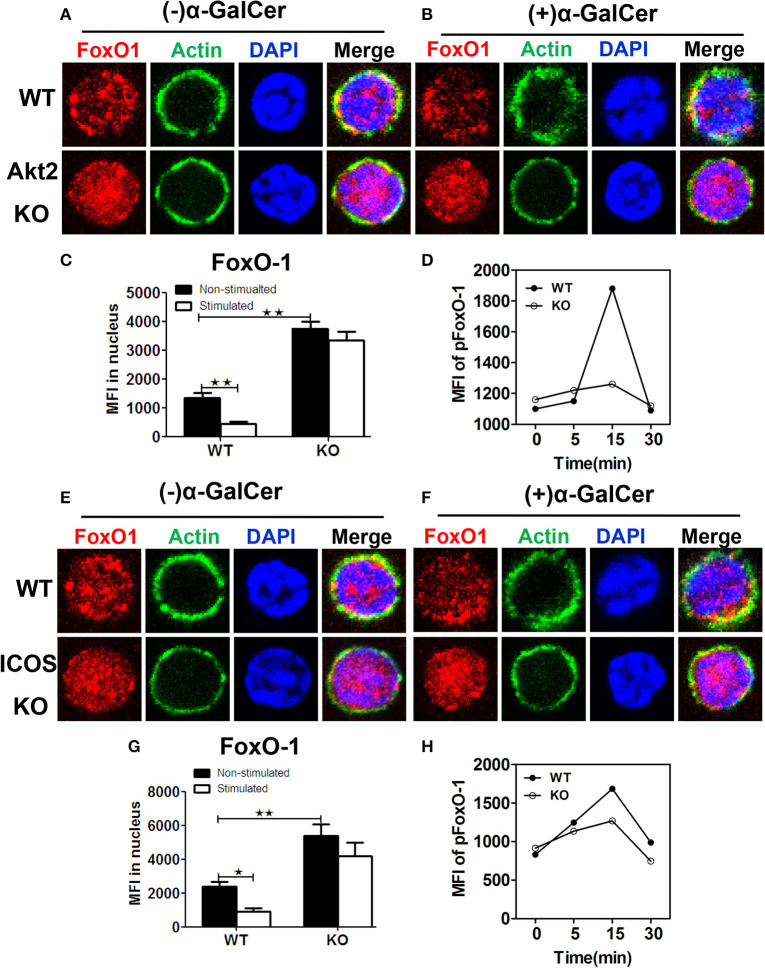
Akt2 couples with FoxO-1 to regulate the expression of ICOS in NKT cells. (A) MACS—enriched and FACS—sorted iNKT cells from WT and Akt2 KO thymocytes were fixed and stained with a rabbit-anti-FoxO1 and AF488-Actin as primary antibody, detected with a goat anti rabbit secondary antibody. The nuclei were stained with DAPI. (B) MACS—enriched and FACS—sorted iNKT cells from WT and KO thymocytes were incubated with125 ng/mL α-GalCer for 3 d and then stained with FoxO1 and AF488-Actin as primary antibody, detected with a Goat anti mouse secondary antibody. (C) MFI of FoxO1 of iNKT cells in the thymus from the WT and Akt2 KO mice (n = 3) quantified with NIS-Elements AR 3.2 software. (D) Phospho flow analysis of the MFI of pFoxO-1(S256) in the WT and KO thymocytes. (E) MACS—enriched and FACS—sorted iNKT cells from WT and ICOS KO thymocytes were fixed and stained with a rabbit-anti-FoxO1 and AF488-Actin as primary antibody, detected with a goat anti rabbit secondary antibody. The nuclei were stained with DAPI. (F) MACS—–enriched and FACS—sorted iNKT cells from WT and ICOS KO thymocytes (n = 3 mice per group) were incubated with125 ng/mL α-GalCer for 3 d and then stained with FoxO1 and AF488-Actin as primary antibody, detected with a Goat anti mouse secondary antibody. (G) MFI of FoxO1 of iNKT cells in the thymus from the WT (n = 3) and ICOS KO mice (n = 3) quantified with NIS-Elements AR 3.2 software. (H) Phospho flow analysis of the MFI of pFoxO-1(S256) in the WT and ICOS KO thymocytes from three independent experiments. *p < 0.05; **p < 0.01, Student's t-test.